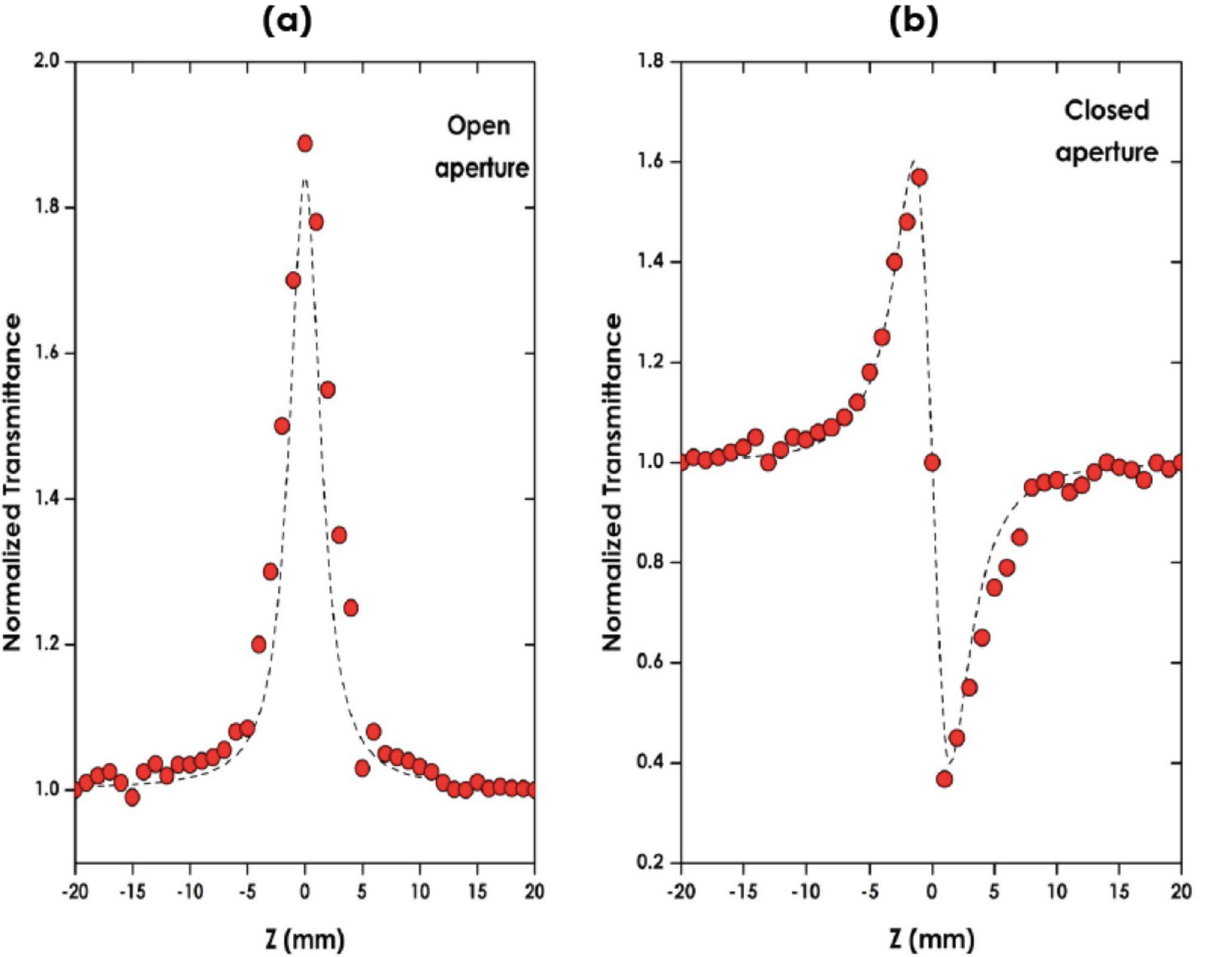
Figure 6. ( a ) The open aperture Z ‒ scan profile of lycopene, ( b ) The closed aperture Z–scan profile exhibiting a peak followed by a valley normalized transmittance indicating that the Lycopene exhibits self-defocusing behaviour and, a negative nonlinear index of refraction. The symbols are the experimental data. The solid lines are the best-fit curves calculated by the Z-scan